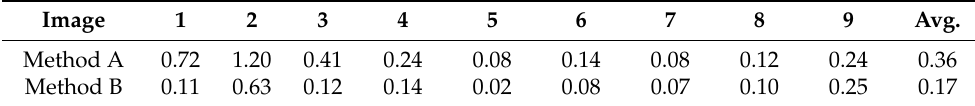
Table 1. Flood depth error results of the comparison of method A and B in FloodMask in the regular scenario (meter).